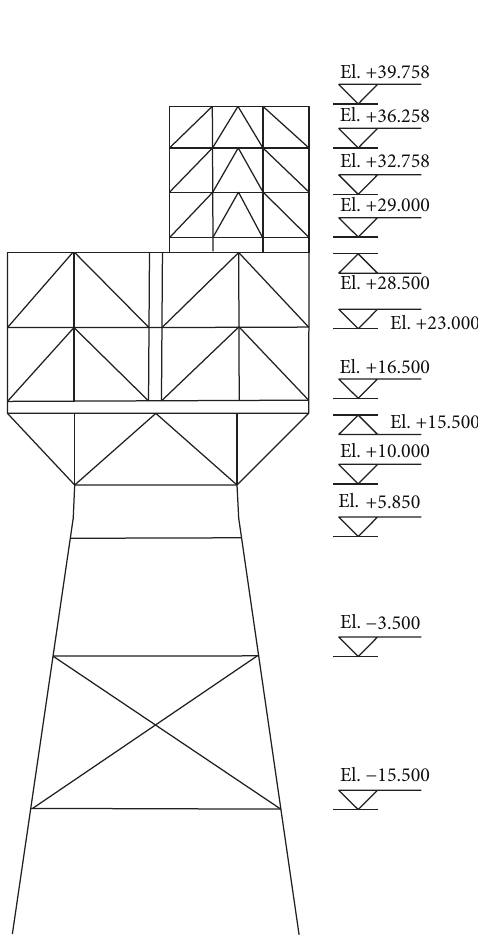
Figure 2: Elevation view of